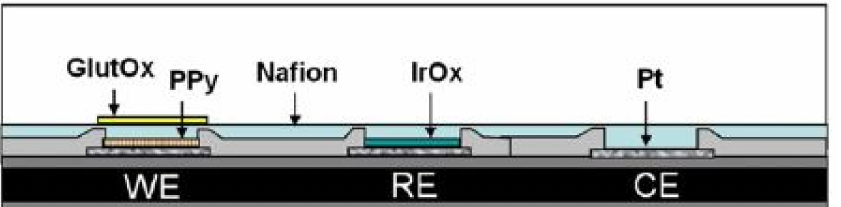
Figure 12. The schematic of fabrication configuration. Reprinted with the permission of reference [66]. Copyright 2012 Elsevier B.V.